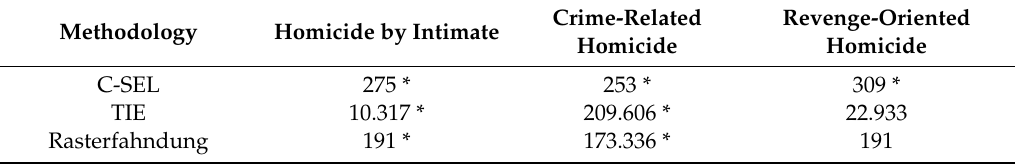
Table 4. Summary of results from the collection phase showing the approximate maximum number of persons of interest when using the case-specific element library (C-SEL), Trace Investigate Evaluate (TIE), and Rasterfahndung. * indicates that the perpetrator was in this group. Approximations were made for element GO1, based on O ff ermans, Priem, and Tennekes [36] and element GO6, based on van Asselt-Goverts, Embregts, Hendriks, Wegman, and Teunisse [37]. For the other elements, the number of persons of interest in the complete case file that met these elements was used. The approximations for TIE and Rasterfahndung were taken from Sutmuller et al.